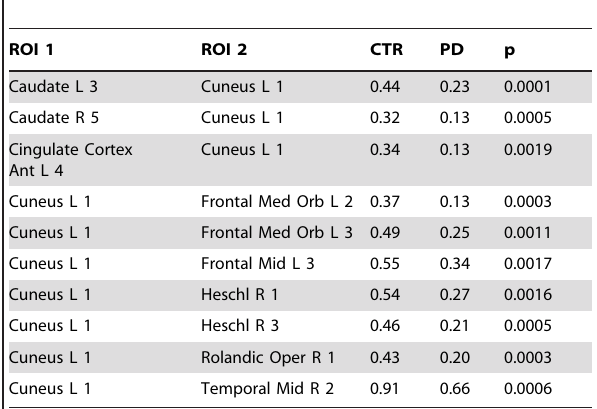
Table 4. Altered connectivity of nodes within module 4 to nodes outside module 4.